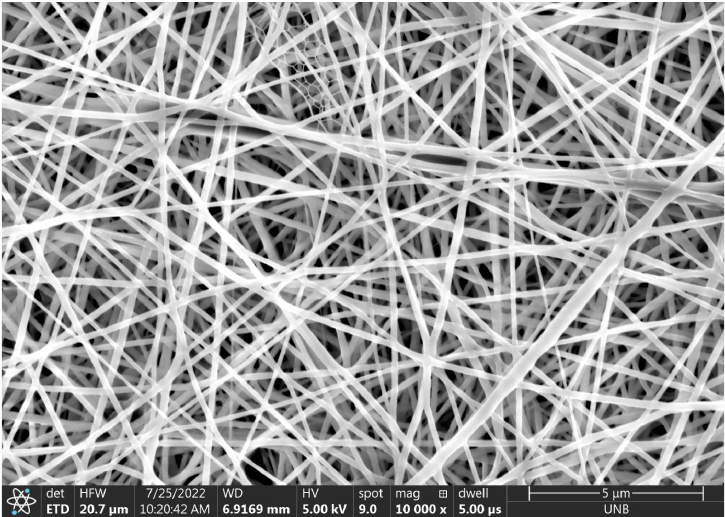
Figure 8. The 10,000x magnification of electrospun fibers from deposit 1. Table 4. Average fiber diameters at each spinning distance for both spinning